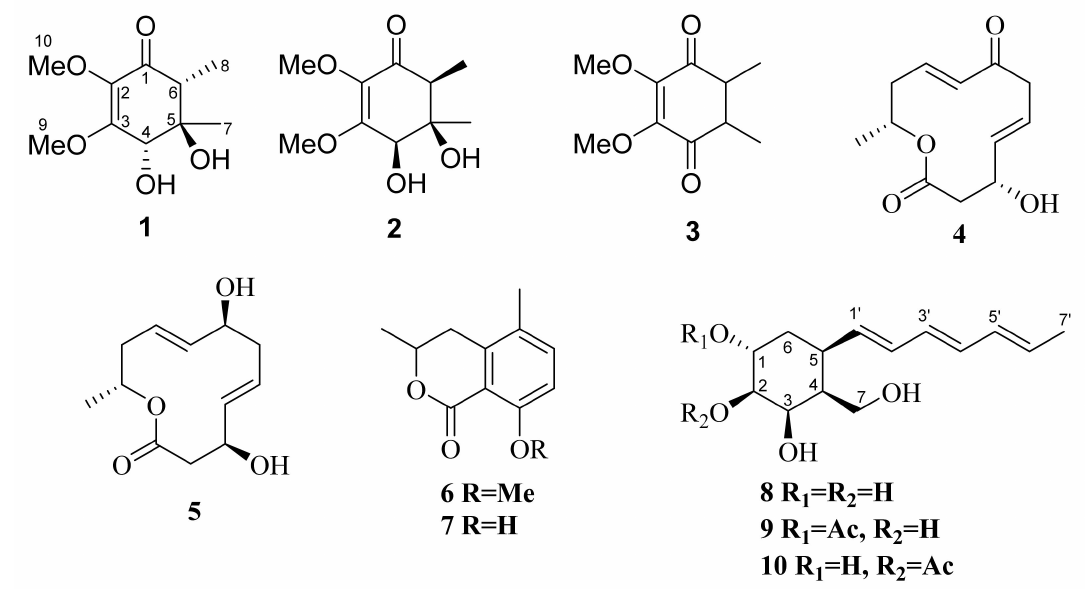
Figure 1. Structures of isolated compounds 1–10